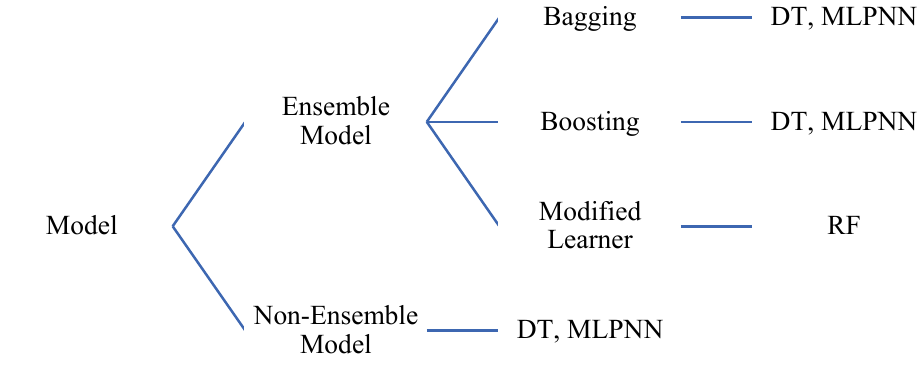
Figure 3. Flow chart of ML